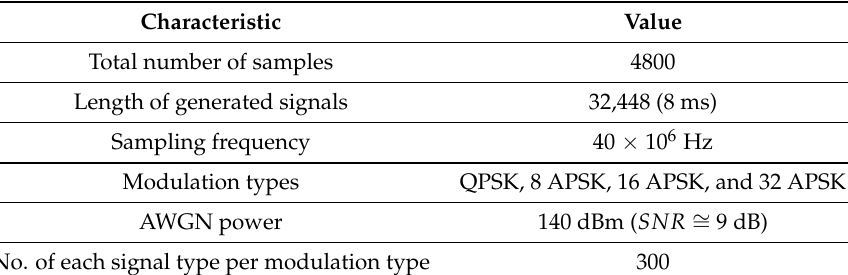
Table 1. Real-time dataset